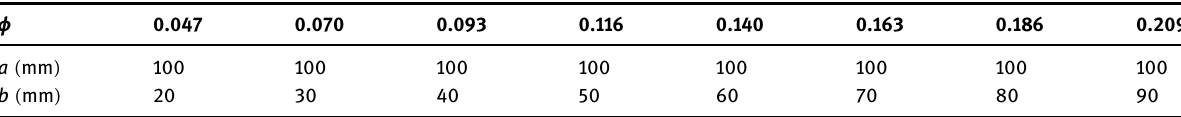
Table 2: Changes in cutout